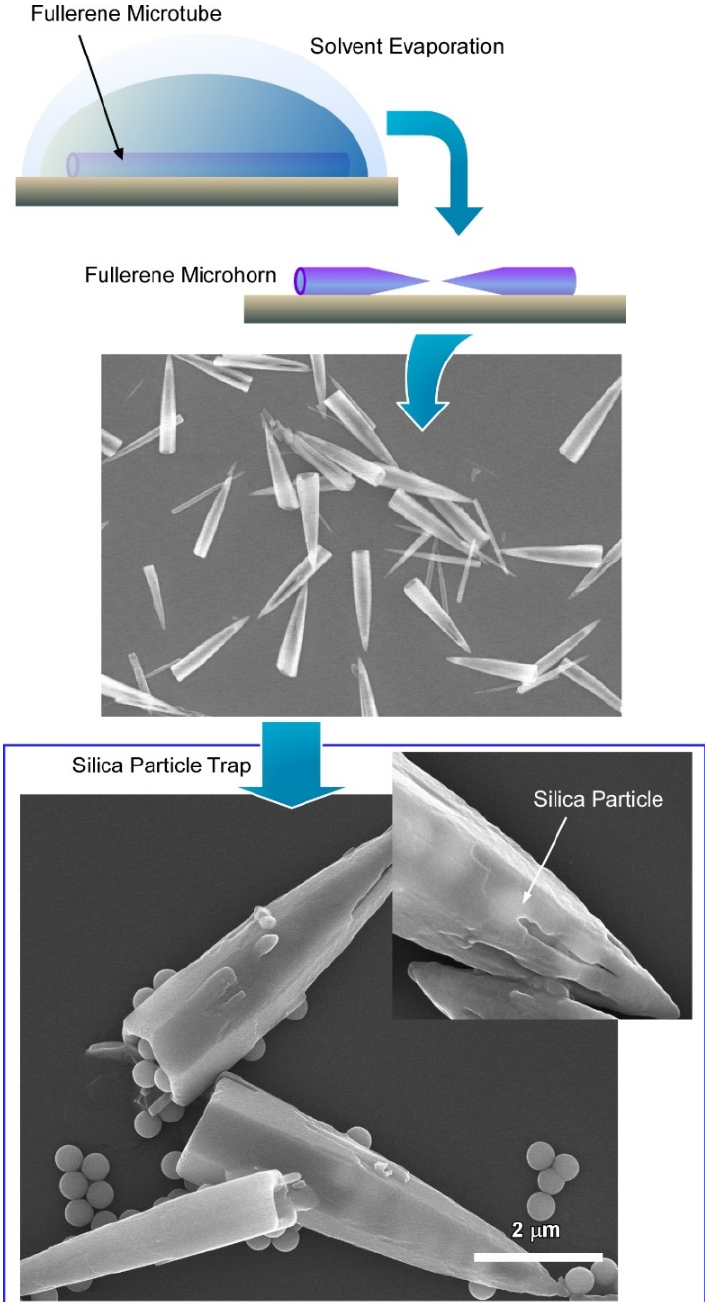
Figure 7. Formation of conical-shaped fullerene microhorn from fullerene microtube and trapping behavior of silica particles. Reprinted with permission from Reference [143]. Copyright 2019 American Chemical Society.